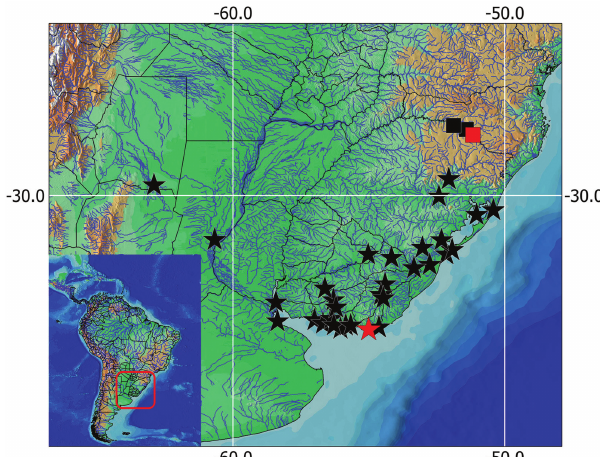
Fig. 6. Map showing the geographical distribution of Corydoras paleatus (stars) and Corydoras froehlichi (squares). The red star represents the Laguna del Diario, Maldonado, Uruguay, one of the plausible places that may be the type-locality of C. paleatus . The red square represents the type-locality of C. froehlichi , rio Pelotas, Rio Grande do Sul, Brazil. Each symbol may represent more than one locality.